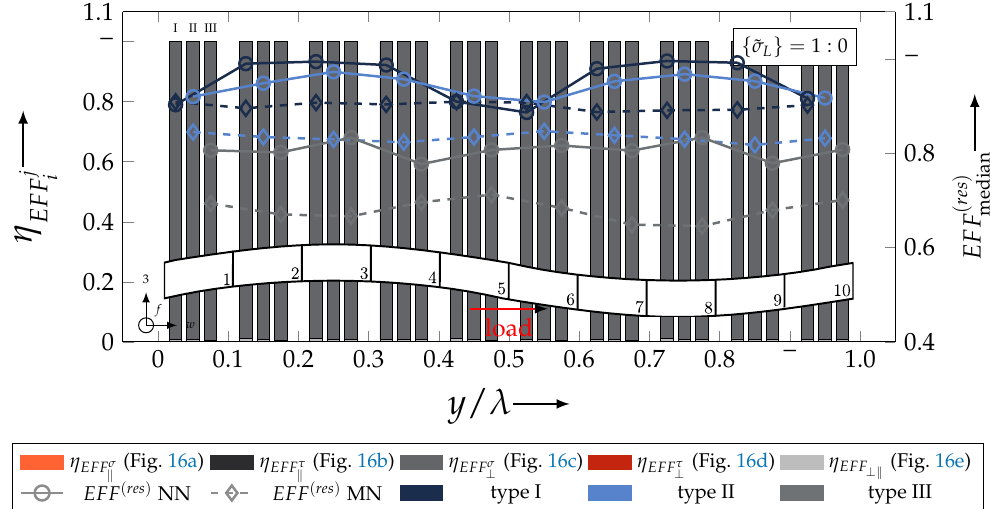
on the resultant stress effort of EFF j i ( res ) of MN and NN configs. at damage initiation median